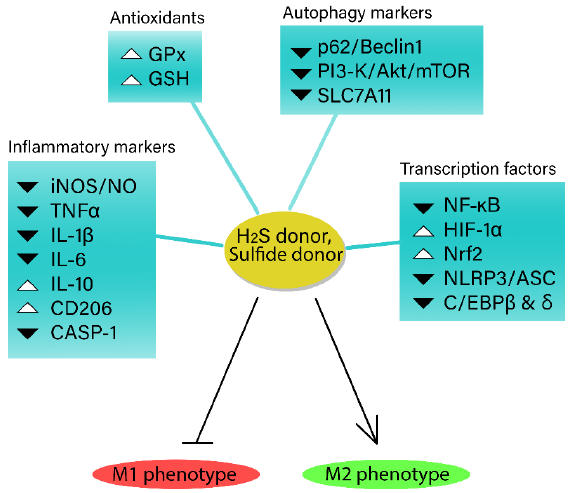
Figure 2. The role of exogenous hydrogen sulfide (H 2 S) in macrophage inflammatory phenotype. H 2 S helps regulate inflammatory responses, while also interacting with pro-inflammatory markers, transcription factors, and proteins to modulate macrophage inflammation. H 2 S donors have demon- strated potential therapeutic benefits in various inflammatory conditions, characterized by inducing anti-inflammatory M2 phenotype in macrophages, highlighting their promise as treatment options.